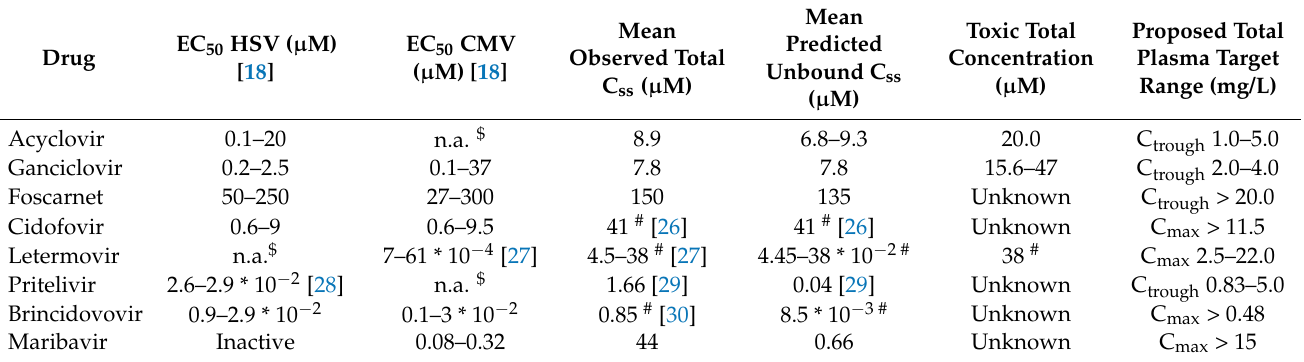
Table 1. Comparison of effective concentration in vitro to the observed concentration in plasma at standard dosing and potentially toxic concentration and proposed total plasma target range. The following variables were taken into account for the proposed total plasma target range (mg/L): mean observed total Css, toxic total concentration, in vitro EC 50 concentrations for HSV and CMV, and the percentage of plasma protein binding. It is recommended to use model informed precision dosing (MIPD) when sampling C max at T max